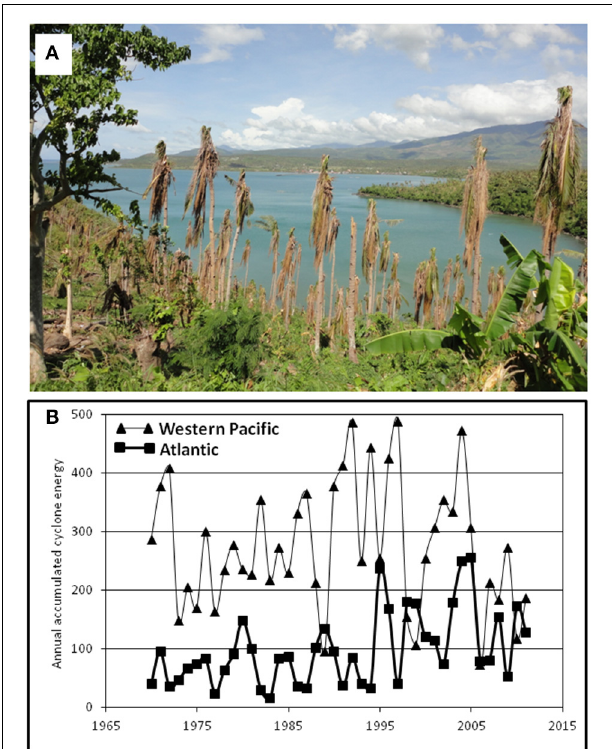
FIGURE 1 | (A) This copra agroforestry system in Leyte was devastated by Typhoon Haiyan in November 2013. It illustrates several key issues of tropical cyclones in the western Pacific that deserve greater research focus, including conversion of coastal sites to human use thereby increasing damage to anthropic systems, devastation of food security, and the need for livelihood restoration. (B) The accumulated cyclone energy per year (knots 2 ∗ 10,000) for the Western Pacific region and the Atlantic